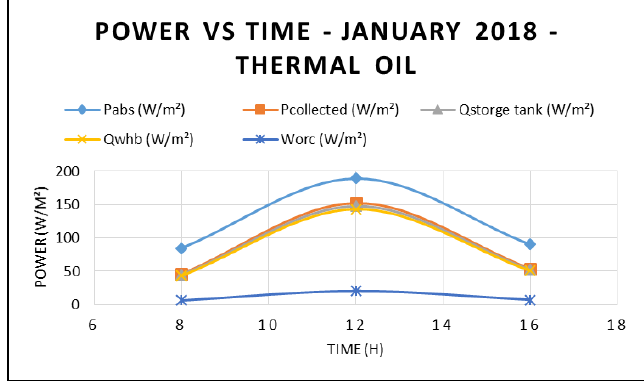
Figure 3. Logical diagram for numerical model.